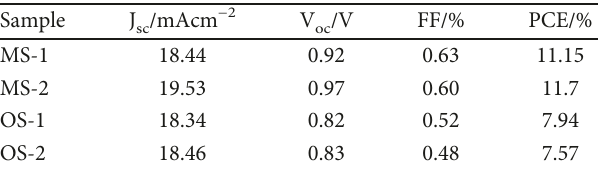
Figure 9: J-V characteristics of devices with CH lms treated by two di ff erent annealing programs. Table 2: Photovoltaic performance parameters extracted from J-V curves (Figure 9).